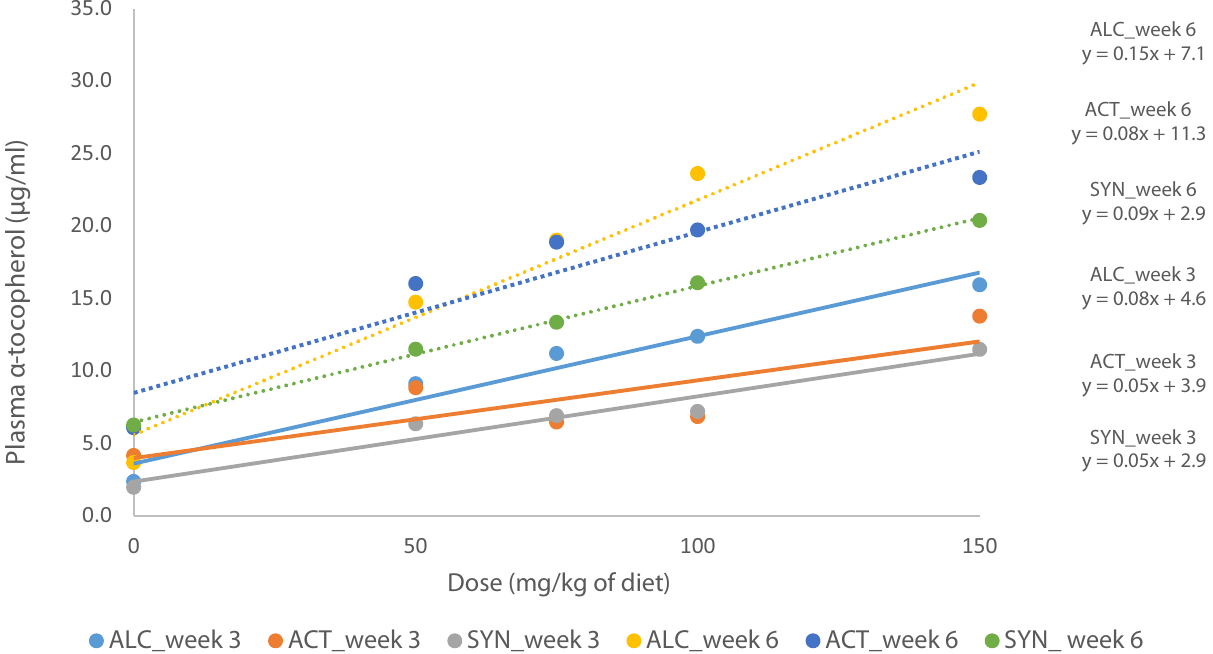
Figure 2. Linear correlation between the plasma α-tocopherol and dose of supplementation in mink kits fed diets supplemented with RRR-α-tocopherol after 6 weeks (ALC_week 6) and 3 weeks (ALC_week 3), RRR-α- tocopheryl acetate after 6 weeks (ACT_week 6) and 3 weeks (ACT_week 3) and all-rac -α-tocopheryl acetate after 6 weeks (SYN_week 6) and 3 weeks (SYN_week 3). Solid line and dashed line represent the LS-means for weeks 3 and 6,